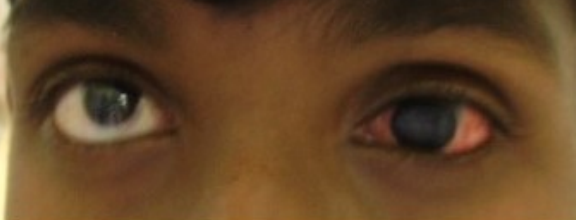
Figure 1: Patient with congestion of the left eye not be made out. Digital intraocular pressure (IOP) was reduced indicating that the eye was phithisical. A diagnos- is of contact lens induced giant papillary conjunctivitis with corneal opacity with phthisis bulbi was made for the left eye. As a routine the right eye was examined, which showed the presence of a brownish coloured ring in the peripheral cornea at the level of Descemet’s membrane, which is classical of K-F ring (Figure 2). The rest of the anterior segment and fundus examination was normal.